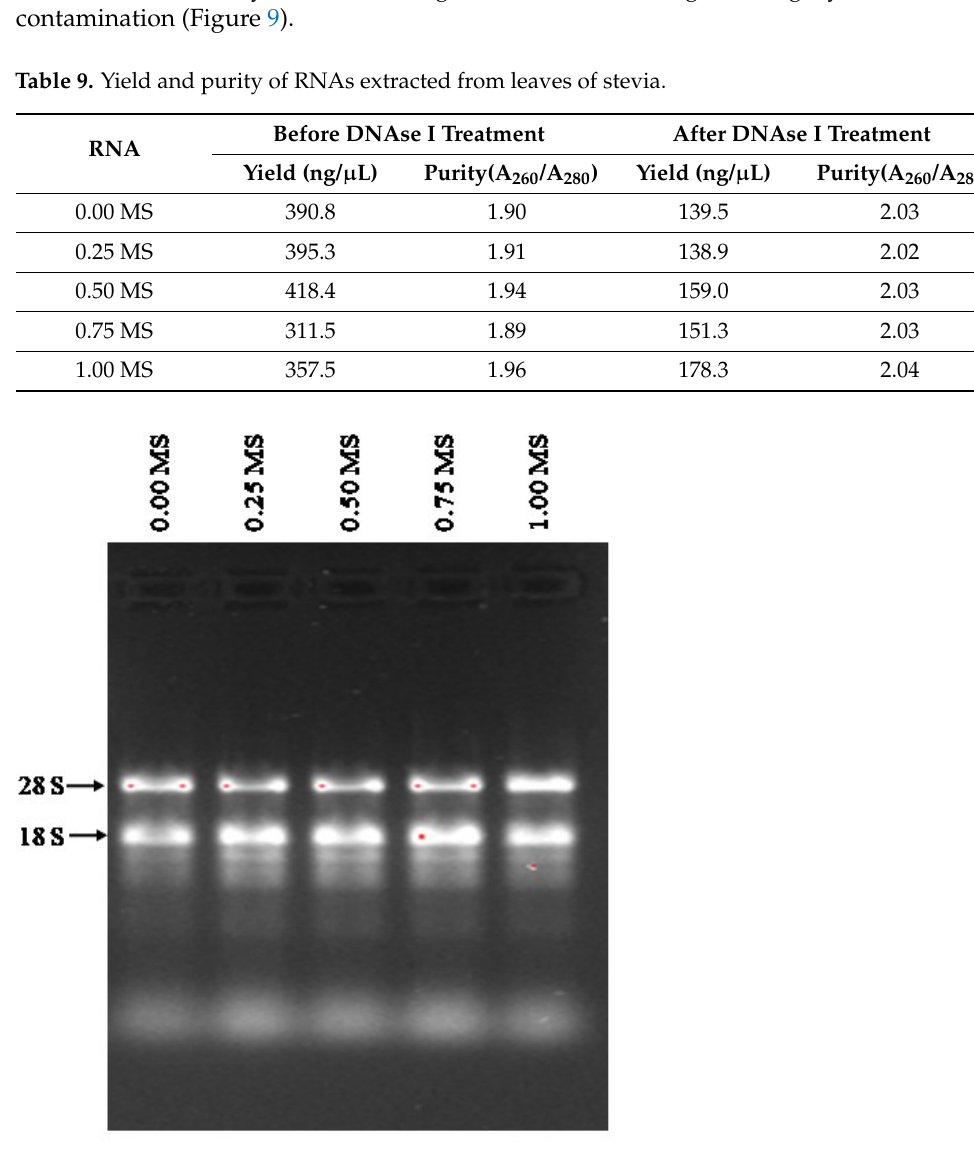
Figure 9. Purified total RNAs isolated from stevia rooted on different strengths of MS (0.00, 0.25, 0.50, 0.75, and 1.00) media. The total RNAs analyzed by electrophoresis on 1.2% ( w / v ) agarose gel.